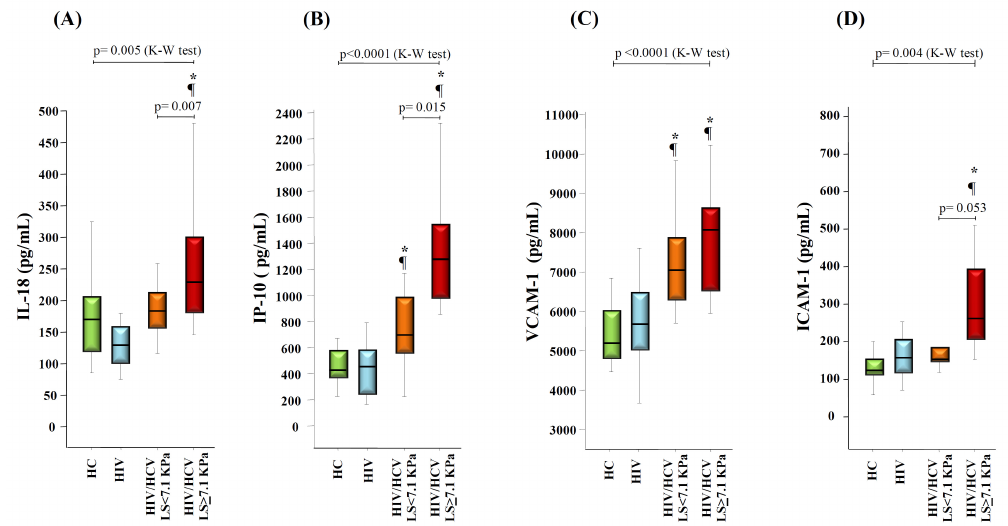
Figure 2. Box-plots graphs showing the levels of IL-18 ( A ), IP-10 ( B ), VCAM-1 ( C ) and ICAM-1 ( D ) in HC donors, HIV monoinfected, and HIV / HCV coinfected patients at baseline (before DAAs treatment) stratified according to level of liver sti ff ness (LS). p -values for global comparison between the groups (Kruskal-Wallis test, K-W) and for the comparison between the two groups of HIV / HCV patients (Mann-Whitney U test) are shown. ( * ): p < 0.05 with respect to HC donors (Mann-Whitney U test). ( ¶ ): p < 0.05 with respect to the HIV group (Mann-Whitney U test).